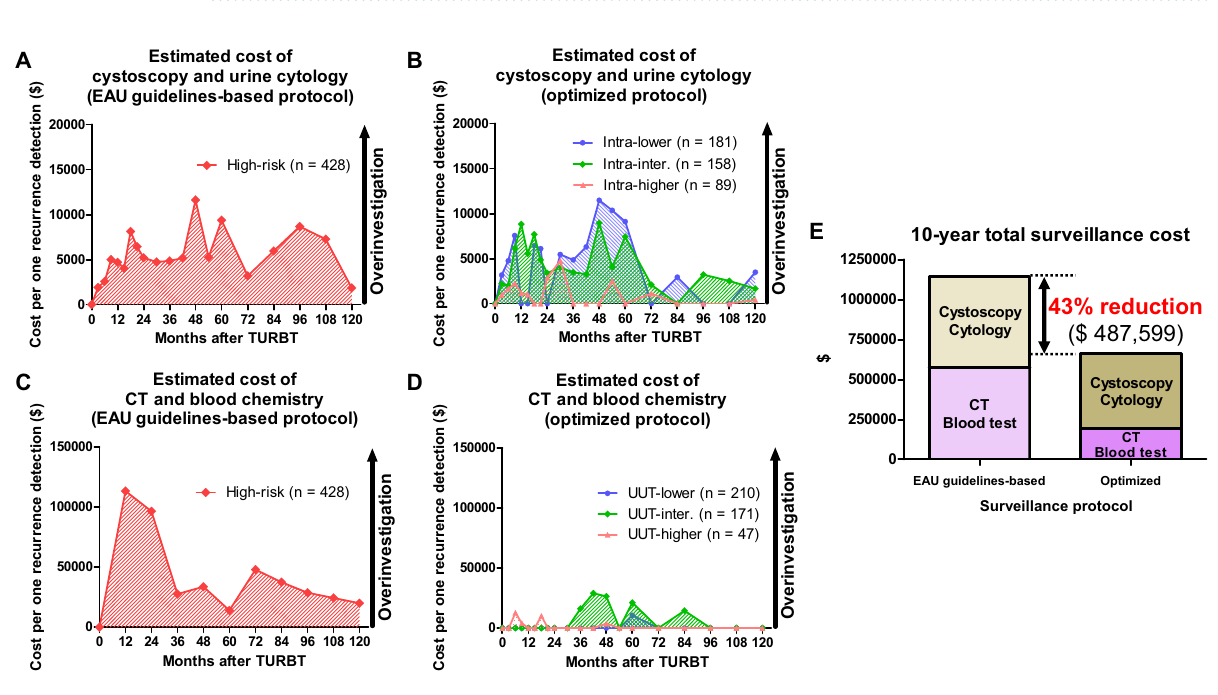
Figure 3. Estimated surveillance costs and 10-year total surveillance cost. Estimated costs of cystoscopy and urine cytology per one recurrence detection ( A : the European Association of Urology [EAU] guidelines-based surveillance protocol and B : the optimized surveillance protocol) were evaluated. Estimated costs of computed tomography (CT) and blood chemistry per one recurrence detection ( C : the EAU guidelines-based surveillance protocol and D : the optimized surveillance protocol) were evaluated. The optimized surveillance protocols promoted a 43% lower ($487,599) 10-year total surveillance cost compared with the EAU guidelines-based protocol ( E ). TURBT, transurethral resection of bladder tumor; UUT, upper urinary